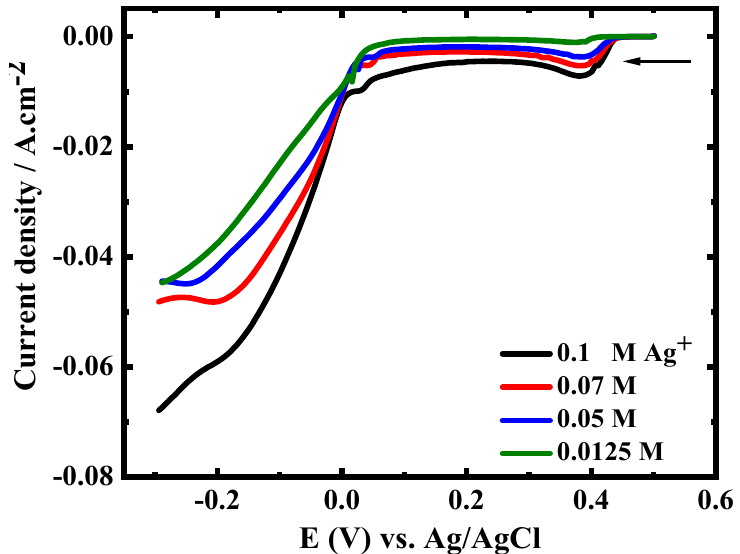
Figure 2. LSVs for CuAg reduction with constant Cu 2+ ions concentration (0.5 M) and varying concentrations of Ag + ions, at GCE, 5 mV s − 1 , and at 27 ◦ C.